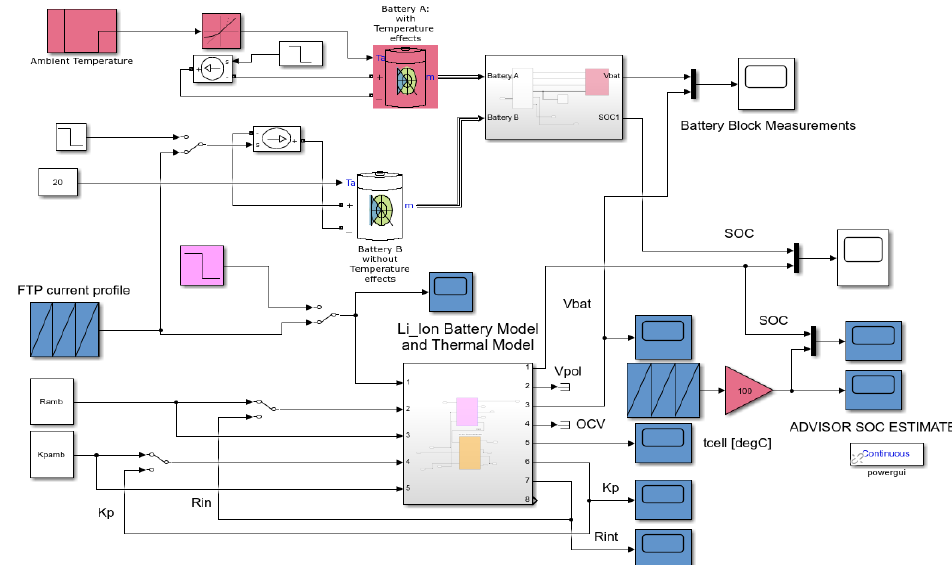
Figure 9. Simulink Simscape model diagram setup that integrates two main blocks. Legend: First block from bottom side encapsulates the Li-ion battery model and Simulink thermal model block; Second block from the top side is a Simscape block with two Li-ion batteries, first one from the top simulate the temperature e ff ects and second one from the bottom of first one doesn’t take into consideration the temperature e ff ects.